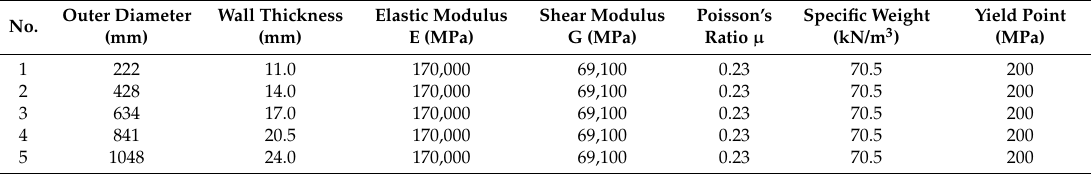
Table 11. Ductile cast iron pipes